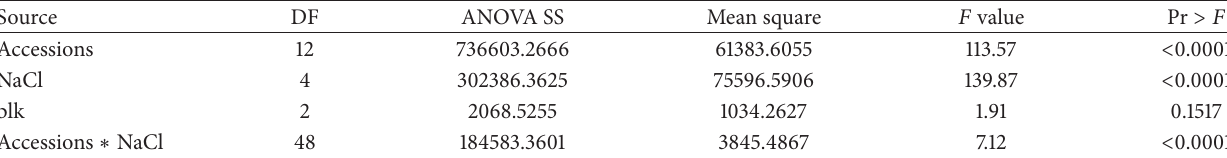
Table 5: ANOVA table for number of leaves with salinity treatments.